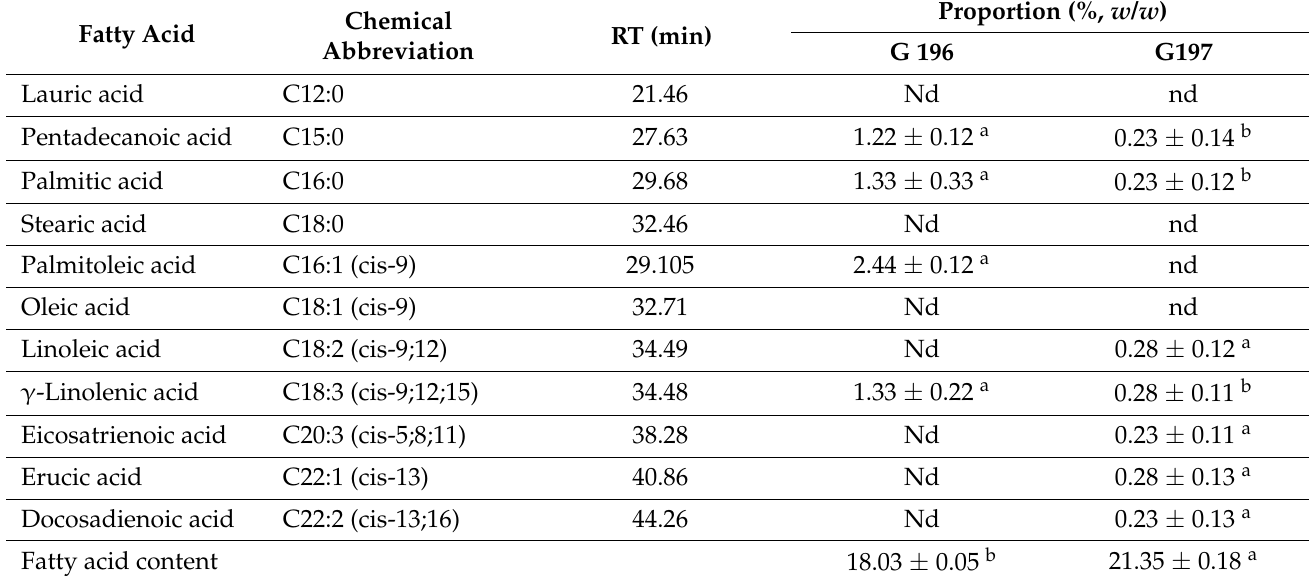
Table 1. Characterization of fatty acids in two soybean